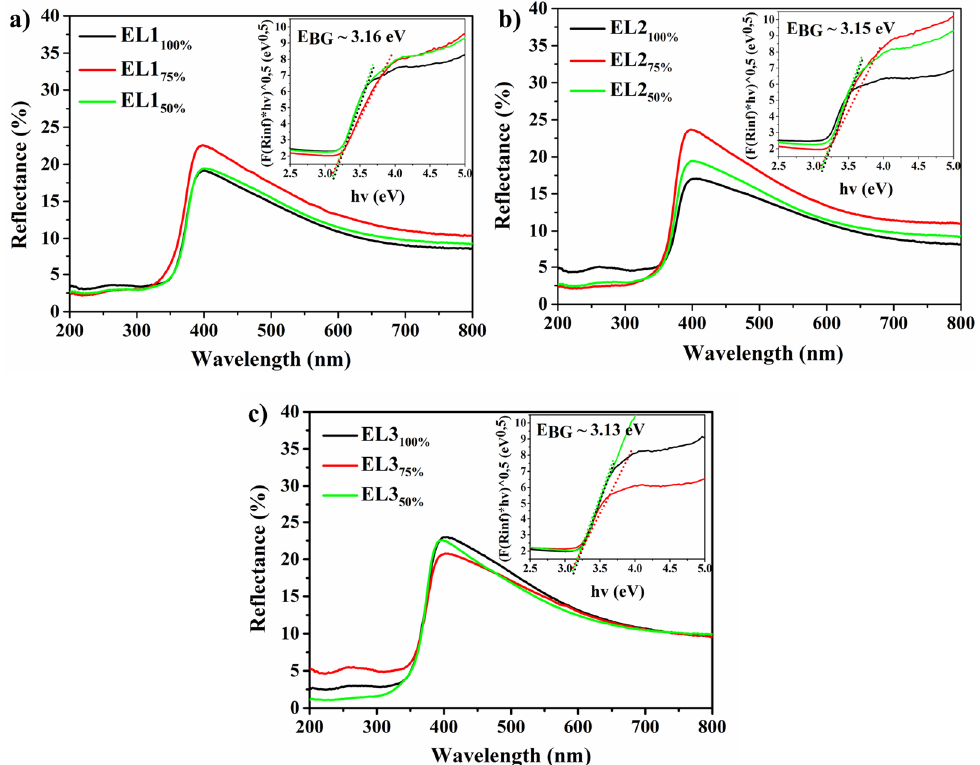
Figure 3. UV-VIS DRS spectra and the corresponding Kubelka–Munk curves (as insets) of TNS prepared in different electrolytes (according to Table 1) at 60 V: ( a ) EL1 50% –EL1 100% , ( b ) EL2 50% –EL2 100% , and ( c ) EL3 50% –EL3 100% .